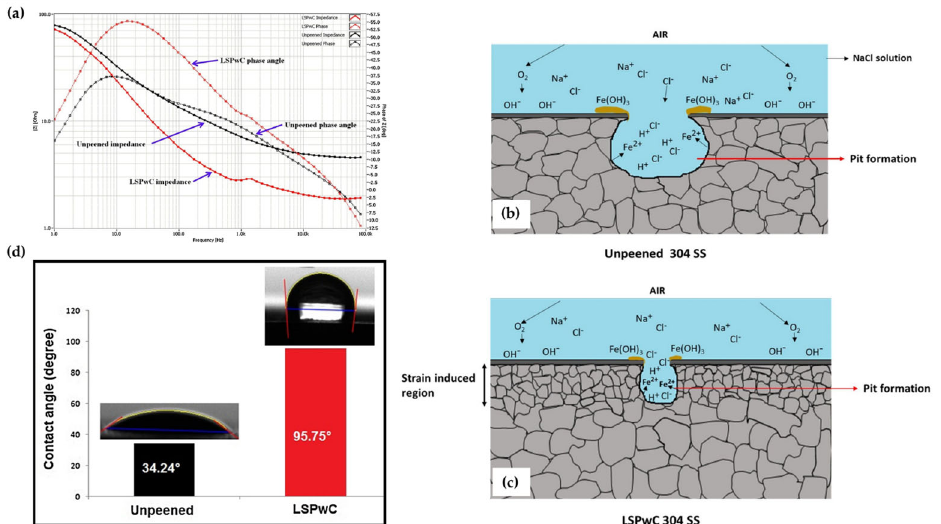
Figure 13. The ( a ) Bode phase and impedance plots as associated pitting corrosion mechanism for ( b ) non ‐ LSPwC and ( c ) LSPwC steel. Additionally, ( d ) the corresponding wettability measurements for these specimens [115].